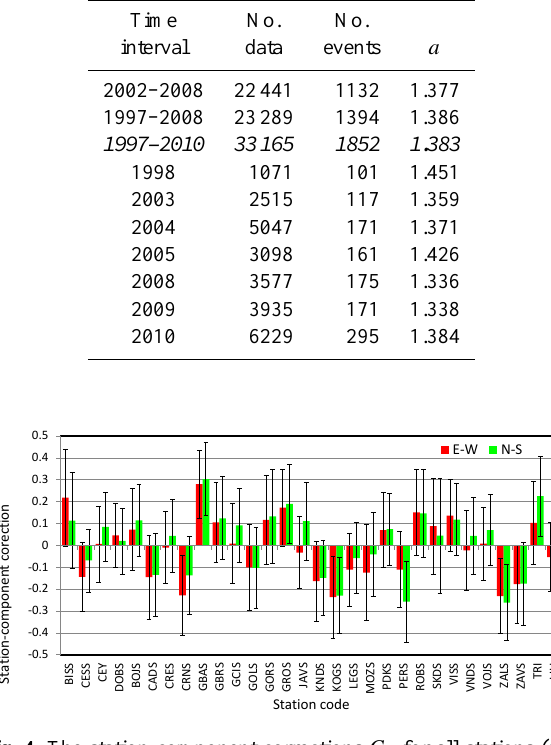
Fig. 4. The station-component corrections C j for all stations (red: EW; green: NS). For the borehole instruments (GOLS, LEGS, PDKS), which do not have standard EW/NS orientations, corrections for components 1 and 2 are shown as EW and NS respectively. Black intervals indicate the ± σ Mj uncertainty intervals.